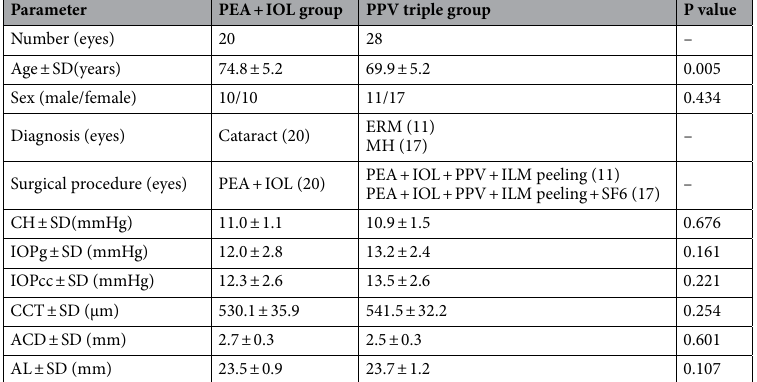
Table1. Demographics of the study population. SD standard deviation, ERM epiretinal membrane, MH macular hole, PEA phacoemulsification and aspiration, IOL intraocular lens, PPV pars plana vitrectomy, ILM inner limiting membrane, SF6 sulfur hexafluoride, CH corneal hysteresis, IOPg Goldmann-correlated intraocular pressure, IOPcc corneal compensated intraocular pressure, CCT central corneal thickness, ACD anterior chamber depth, AL axial